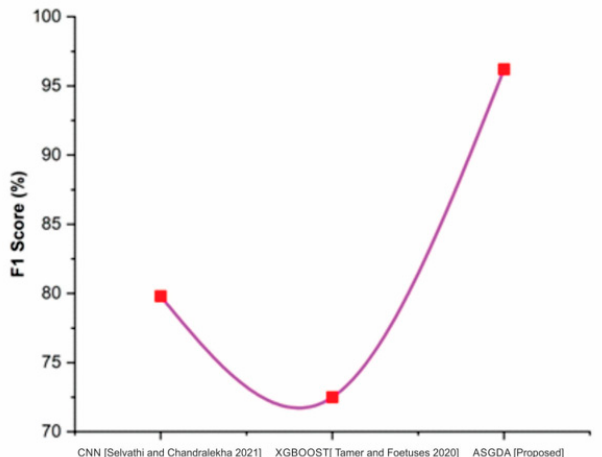
Figure 10. Comparison of recall with the traditional and proposed method [42,43].